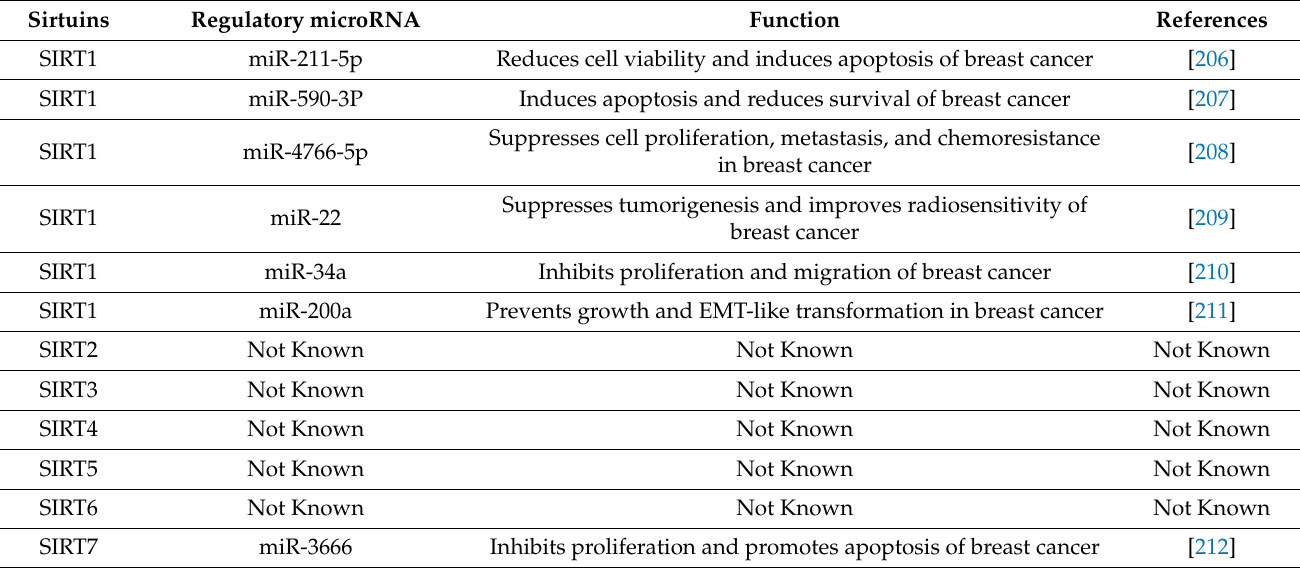
Table 3. Mechanistic Roles of Sirtuins (SIRT1–7) Regulation by miRNAs in Breast Cancer.